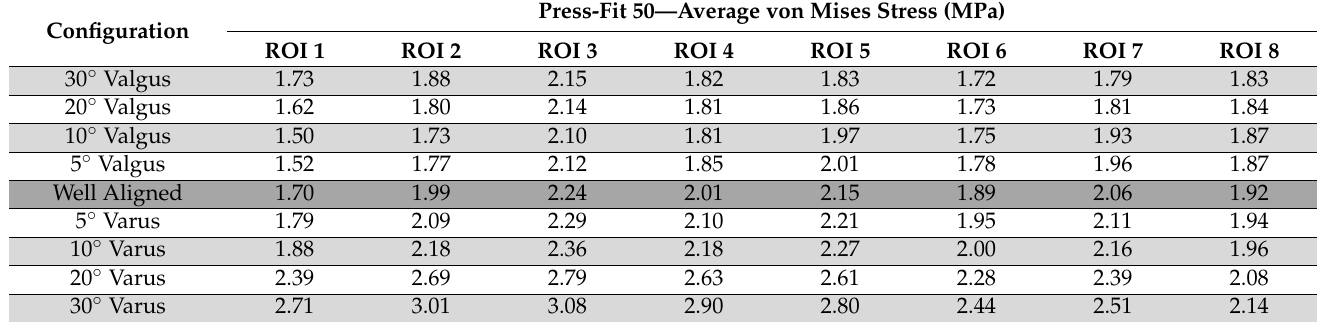
Table 6. Average von Mises stresses (in MPa) in the different ROIs for the 50 mm press-fit stem.